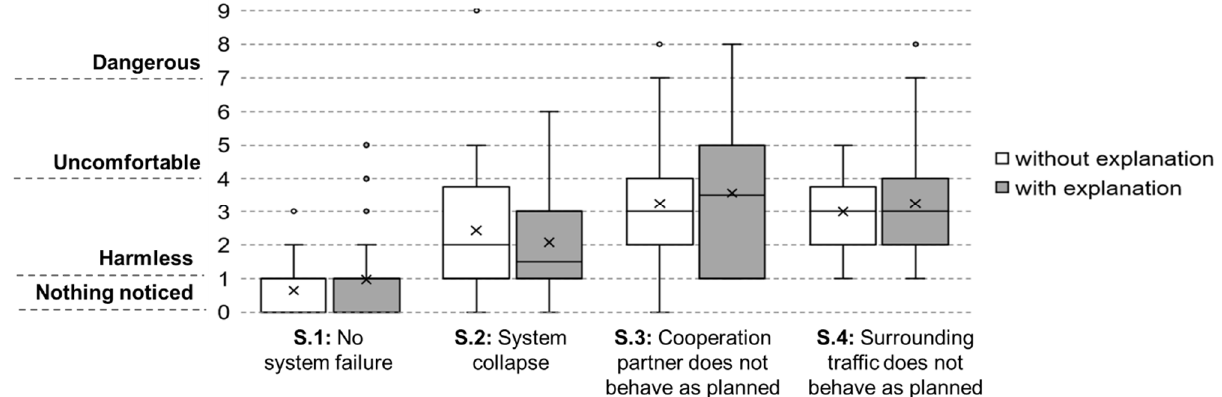
Figure 5. Perceived criticality in the individual route situations in drives with and without explanation text for system failures. Table 4. Descriptive and inferential statistics of the evaluation of HMI with and without explanation.